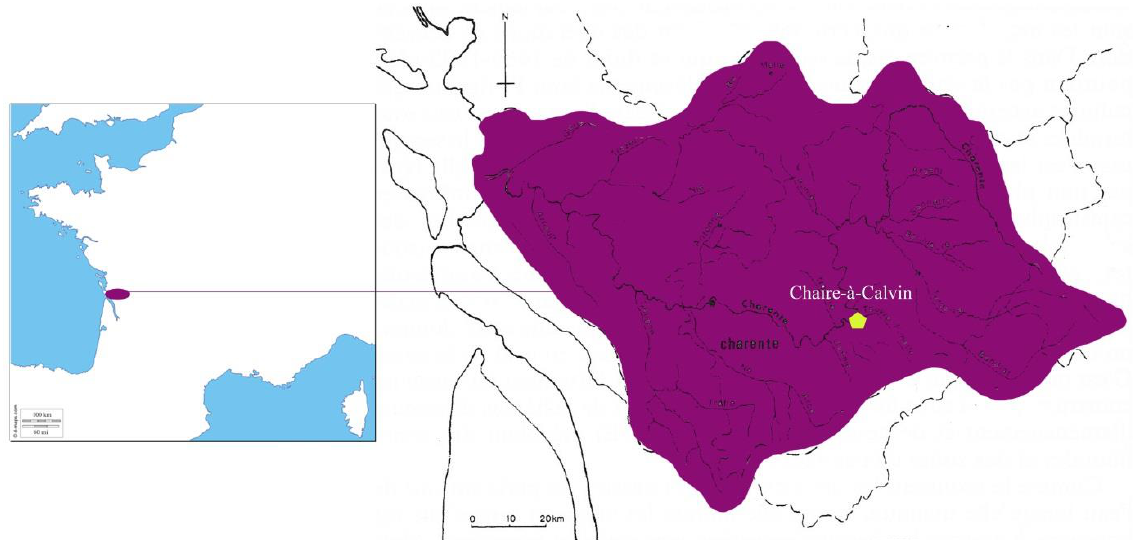
Figure 2. Charente’s basin and the Chaire-à-Calvin site (modified from